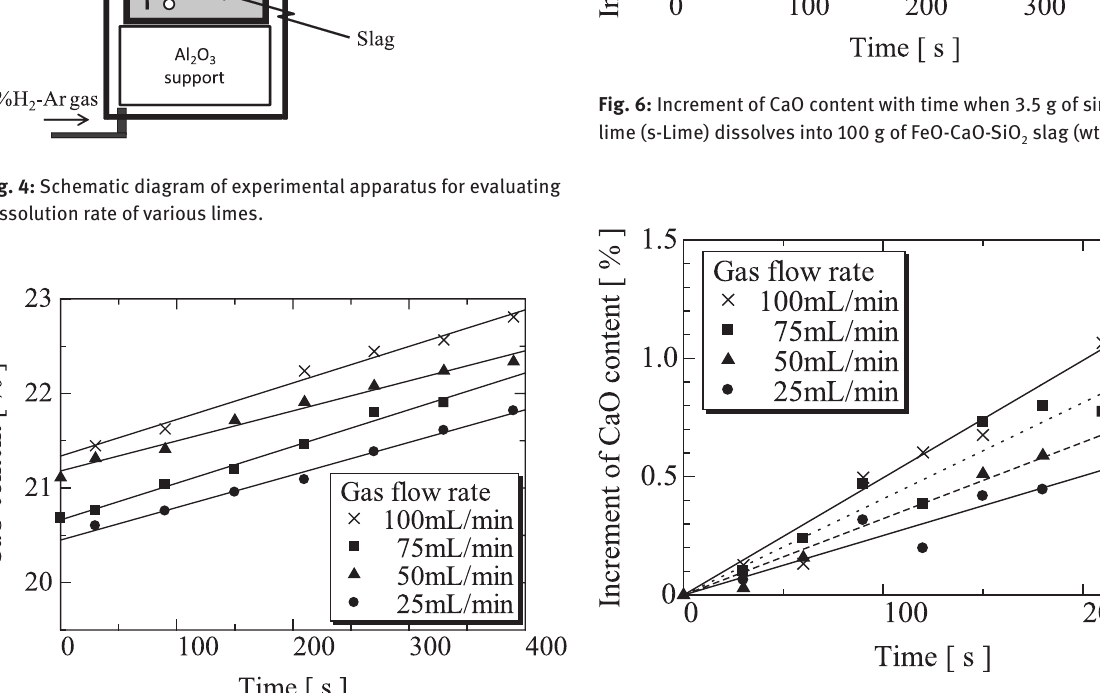
Fig. 5: Concentration change of CaO when 3.5 g of sintered lime (s-Lime) dissolved into 100 g of FeO-CaO-SiO